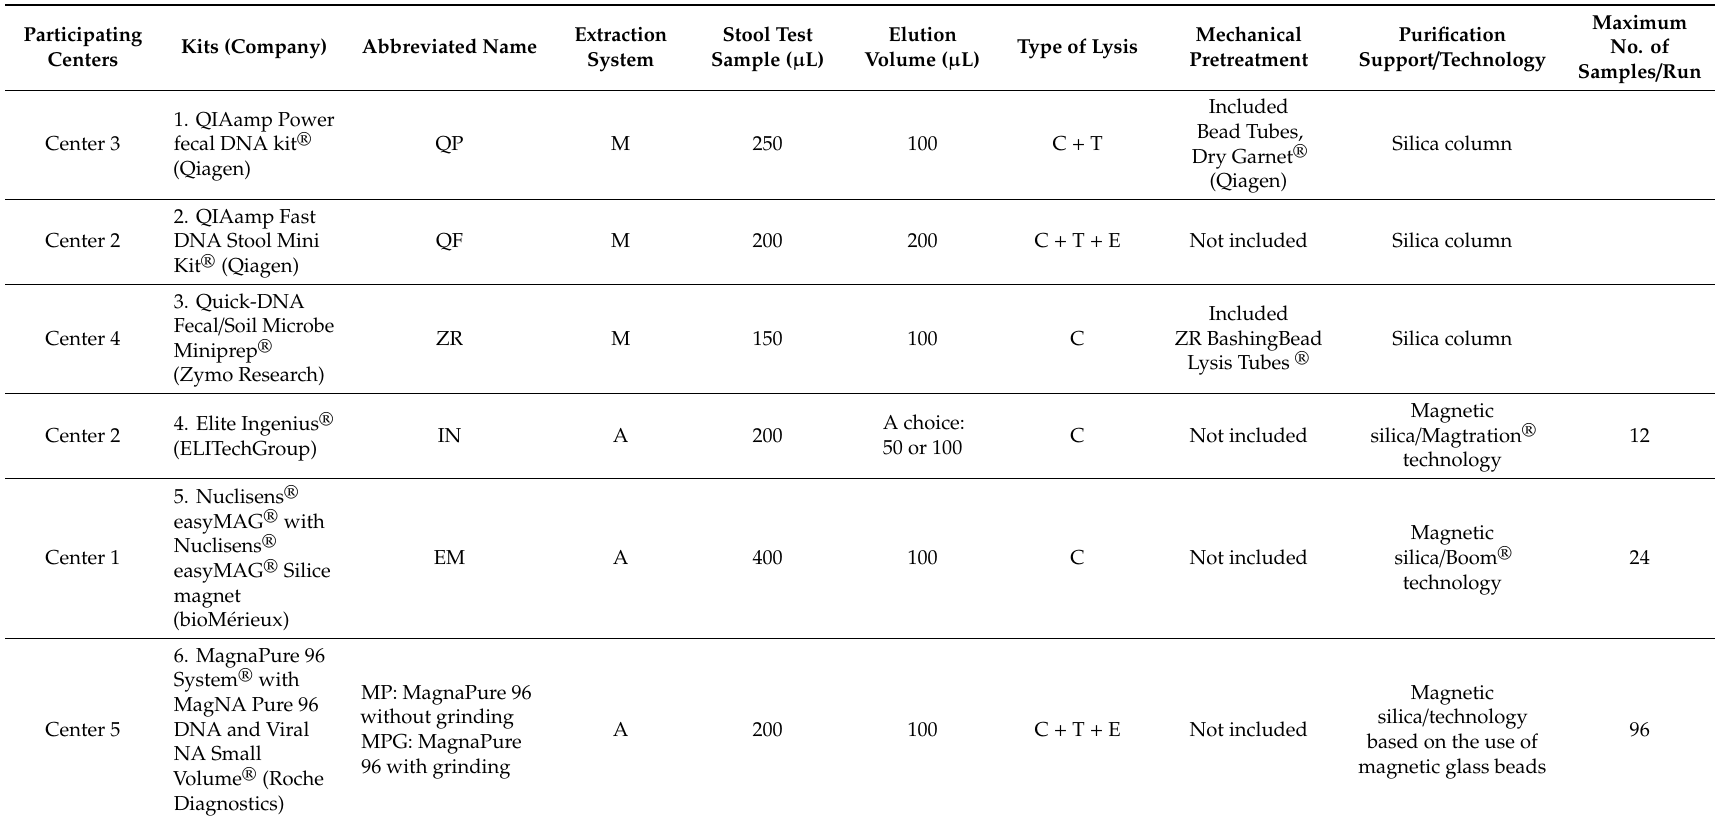
Table 3. Characteristics of the DNA extraction